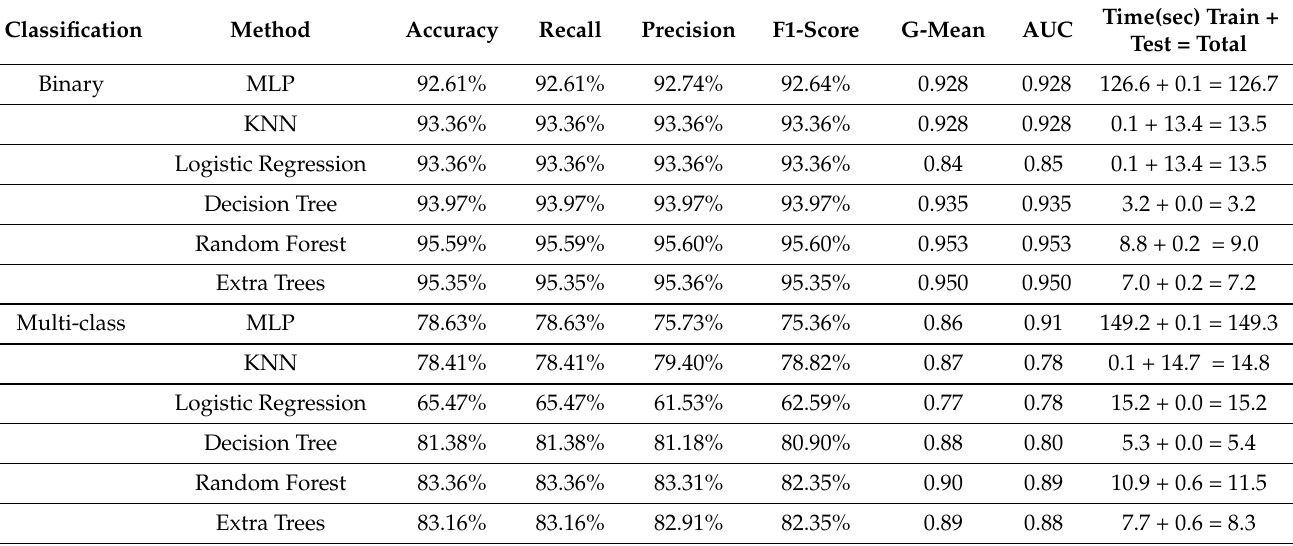
Table 4. Classification results on UNSW-NB15 dataset using chi-square features